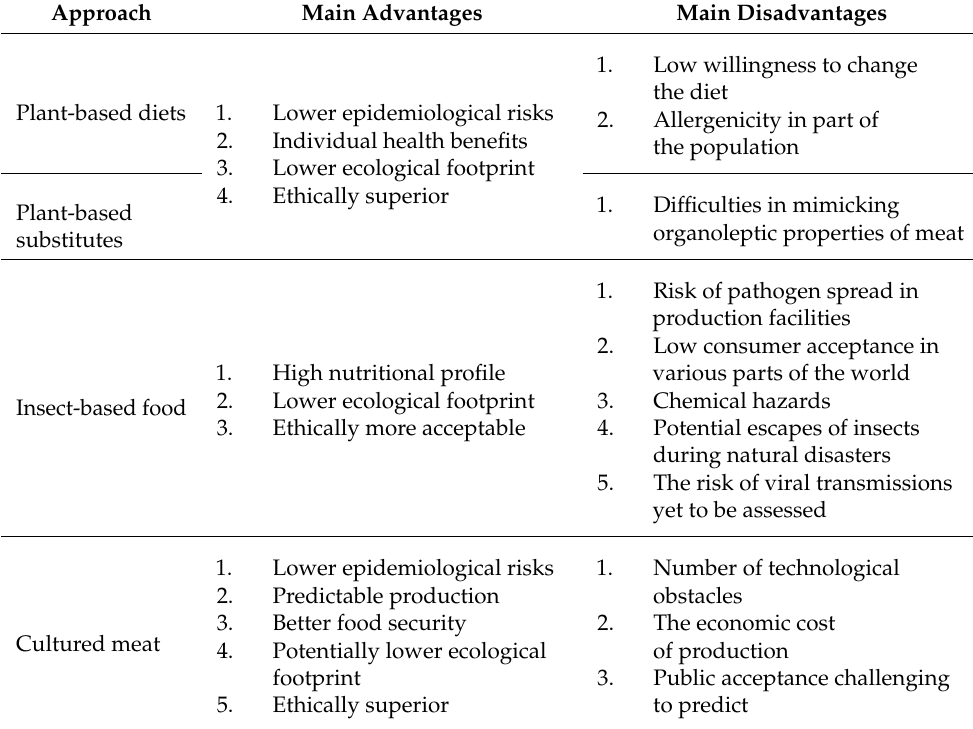
Table 1. Main advantages and disadvantages of approaches discussed in this paper as compared to conventional meat